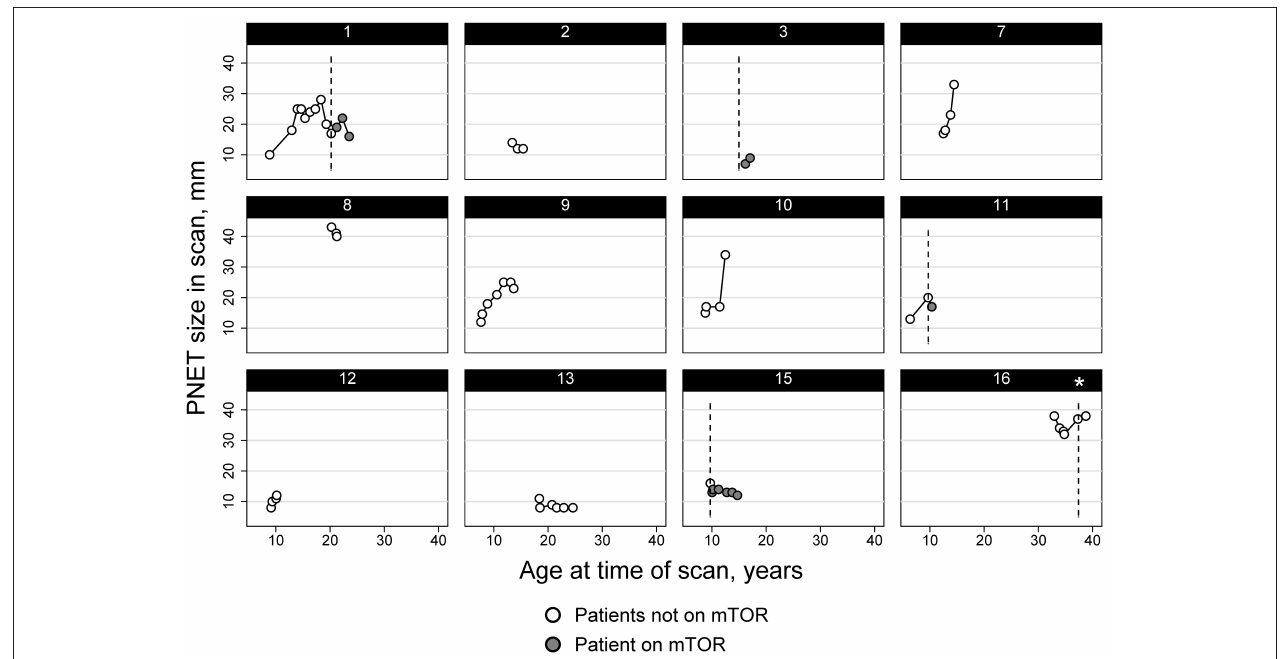
FIGURE 2 | Diameter trend of PNET in subjects from the TS Alliance’s Natural History Database and the Cincinnati Children’s Hospital TSC Database. Asterisk indicates that Subject 16 started and stopped an mTOR inhibitor therapy between imaging and never had any imaging performed while actively taking an mTOR